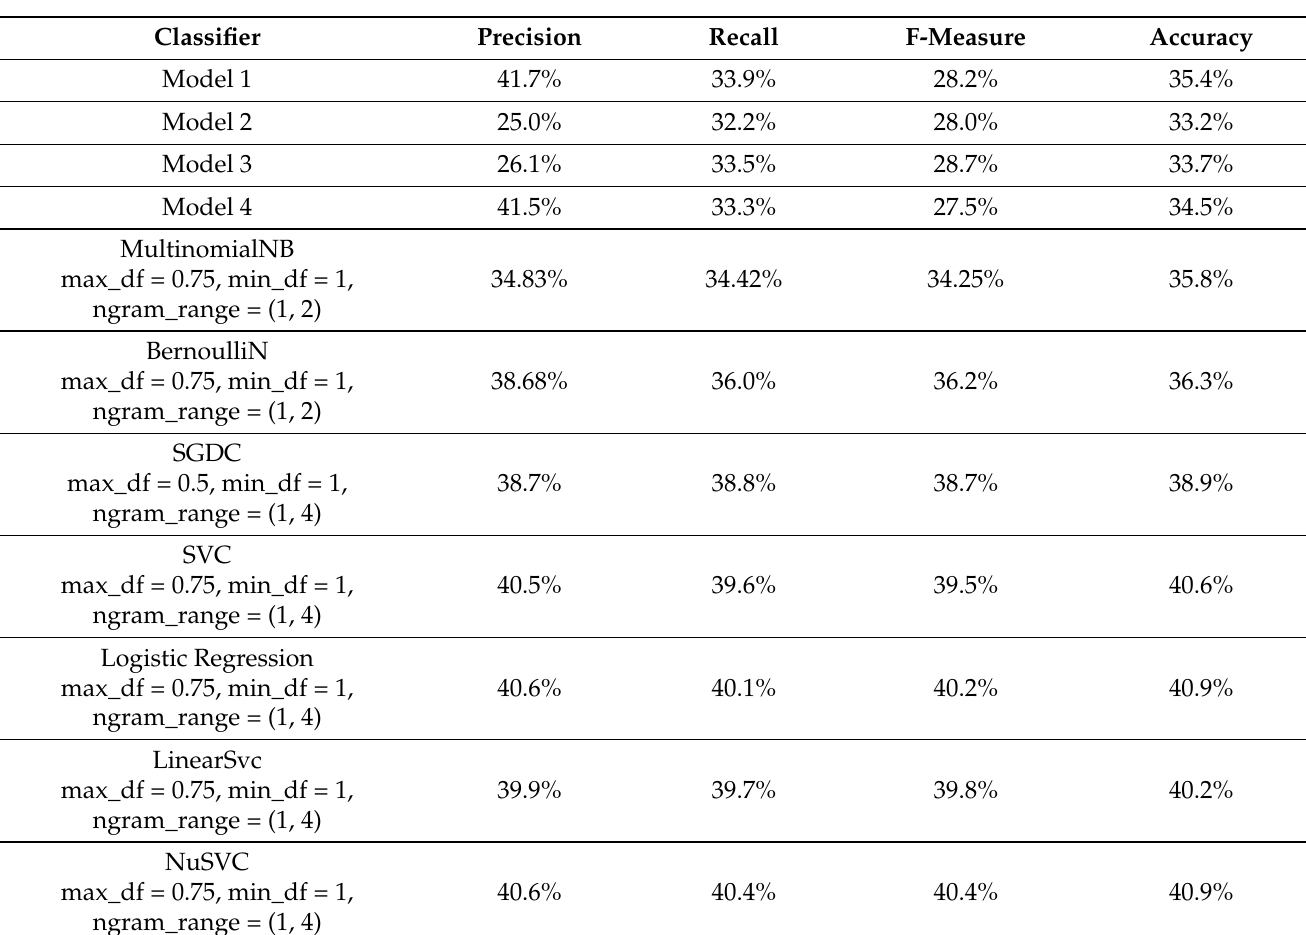
Table 4. Results of four-way ADI